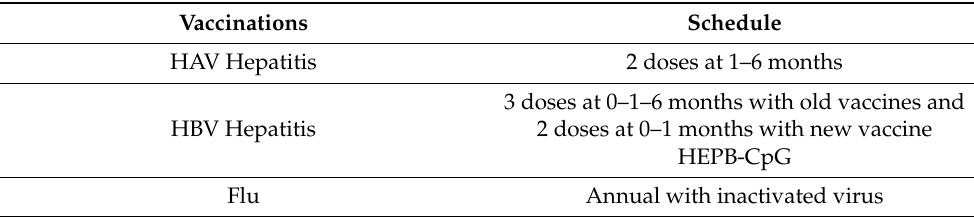
Table 1. Vaccination